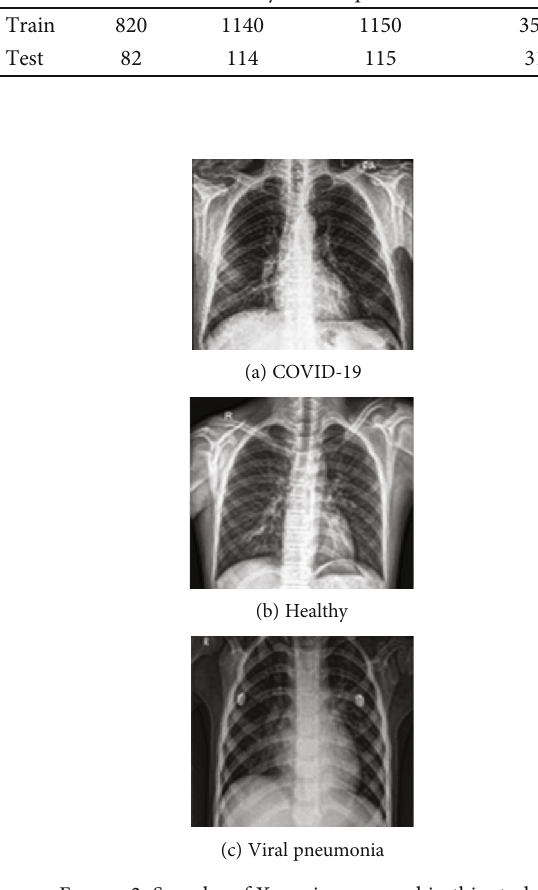
Figure 2: Samples of X-ray images used in this study. Table 2: The parameters of CNNs for transfer learning.